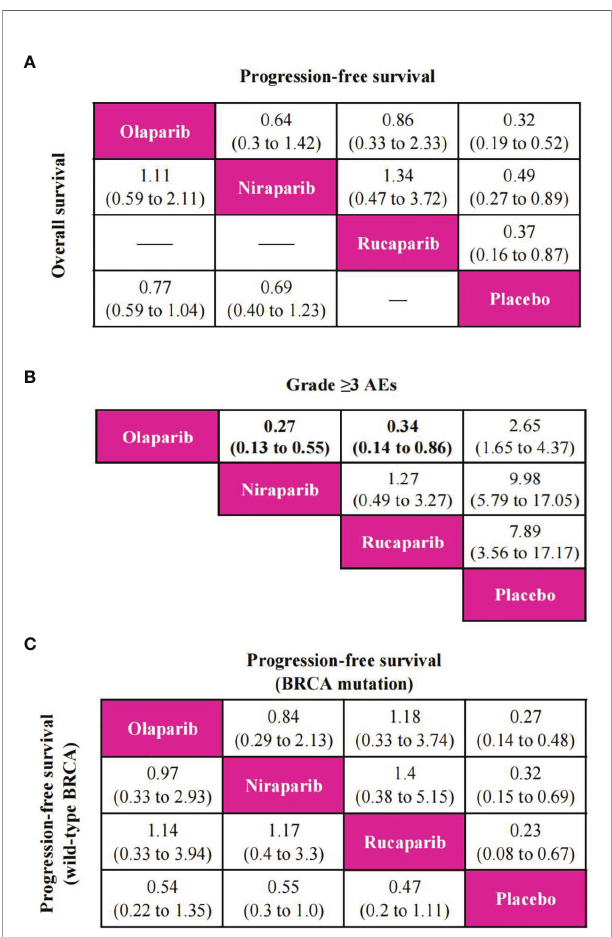
FIGURE 4 | Pooled estimates of the network meta-analysis. (A) Pooled hazard ratios (95% con fi dence intervals) for progression-free survival (upper triangle) and overall survival (lower triangle) in the overall population. (B) Pooled odds ratios (95% con fi dence intervals) for grade ≥ 3 adverse events in the overall population. (C) Pooled hazard ratios (95% con fi dence intervals) for progression-free survival of BRCA mutation population (upper triangle) and wild-type BRCA population (lower